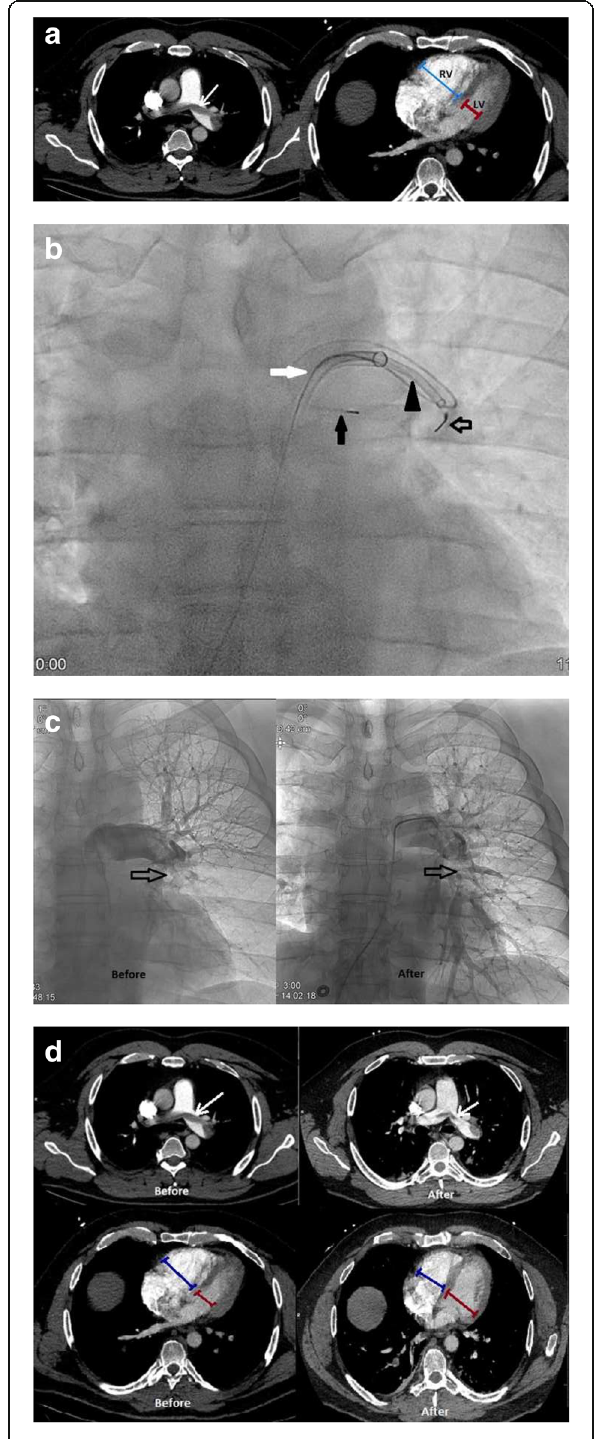
Fig. 11 A 44-year-old male with a left lower extremity DVT after trauma presenting with massive PE, 8 days after initiation of anticoagulation for the DVT. Patient was hypotensive with a BP of 78/45 and troponin I elevation of 0.83 ng/mL. a CTA demonstrates a saddle pulmonary embolus (white arrow) and increased RV/LV ratio with blue calipers demonstrating the diameter of the RV and the red calipers demonstrating the diameter of the LV. b Fluoroscopic images of aspiration thrombectomy. A 90 cm 8Fr Sheath (white arrow) through which is passed an Indigo CAT-8 thrombectomy device (black arrowhead, Indigo, Penumbra, Alameda, CA, USA). Black closed arrow demonstrates a safety wire to stabilize access to the left pulmonary artery. Black open arrow demonstrates the Indigo separator to clear thrombus from the opening of the catheter. c Pulmonary angiogram demonstrates before and after catheter- directed therapy pictures. Arrow demonstrates improved perfusion to the lower lobe. d CTA demonstrates before and after catheter- directed therapy images with improvement in thrombus burden and before and after catheter-directed therapy images with improvement in RV/LV